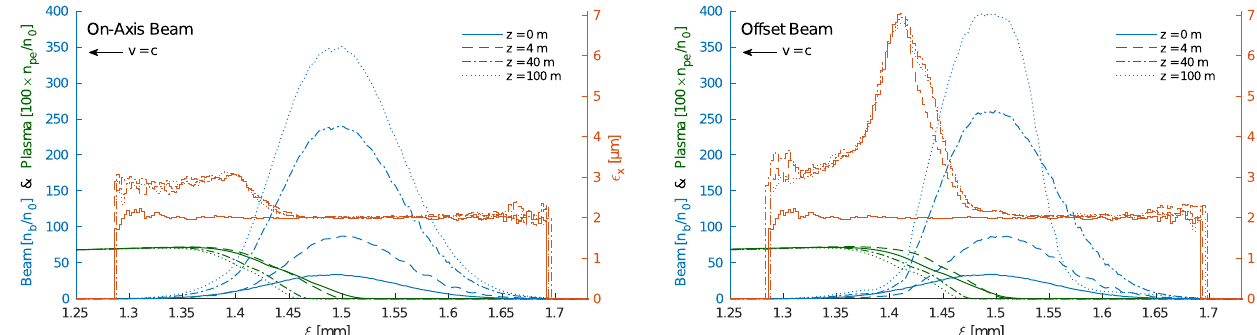
FIG. 5. Beam density in blue along the beam axis for an on-axis beam with respect to the drive beam axis (left), and an offset beam (right) with an offset of one σ x;eb ¼ 5 . 24 μ m in the x-plane — at four different positions z in the plasma stage. The red lines show a moving window calculation of transverse normalised emittance. The moving window calculation uses longitudinal slices of l ¼ 4 · Δ ξ ¼ 9 . 38 μ m with a stepof Δ ξ .Onlysliceswithmorethan100macroparticleshavebeenincluded.Theplasmadensityprofileisincludedingreen,andscaledup by a factor of 100 to be visible. These simulations were run with an LHC energy drive beam of 7